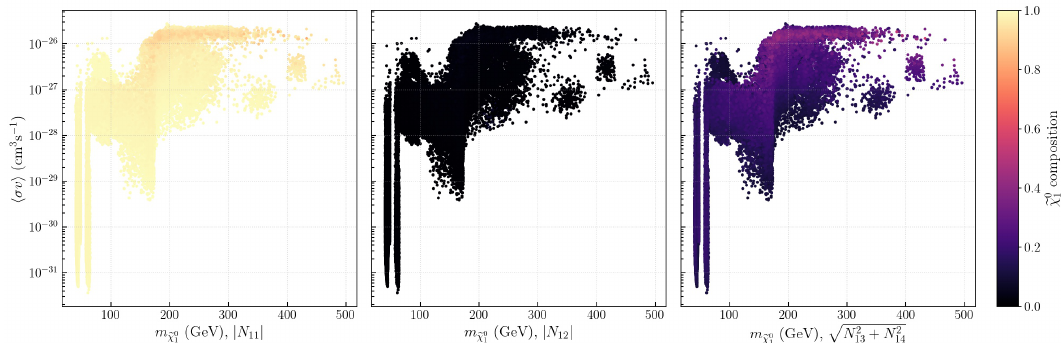
Figure 3: The mass of the DM particle ( m cross section ( 〈 σ v 〉 ). The composition of the LSP is shown as a color code, with the bino component | N and the higgsino component